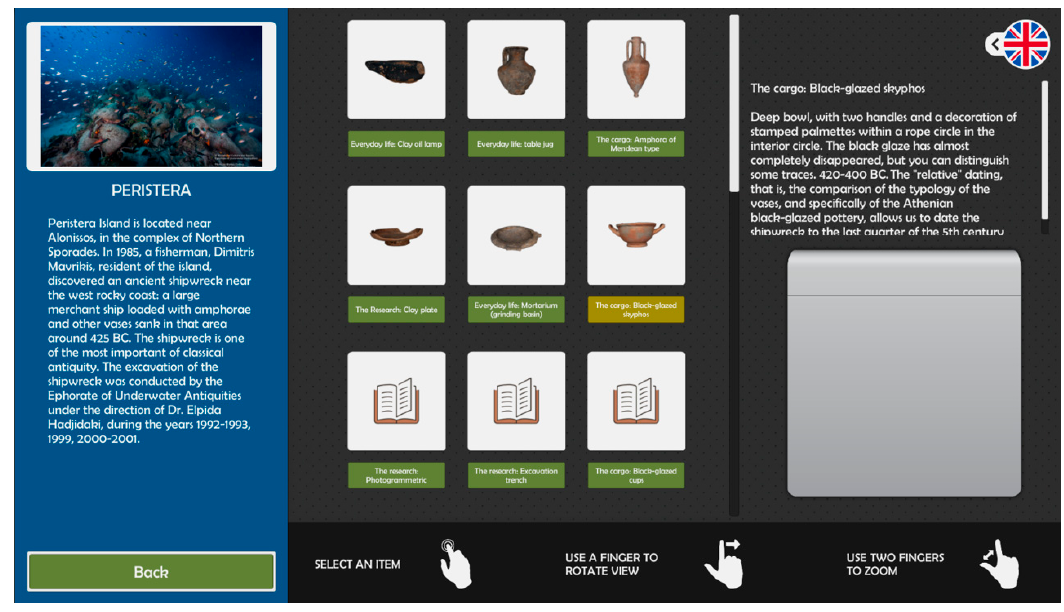
Figure 5. “Virtual Catalogue” and related info.